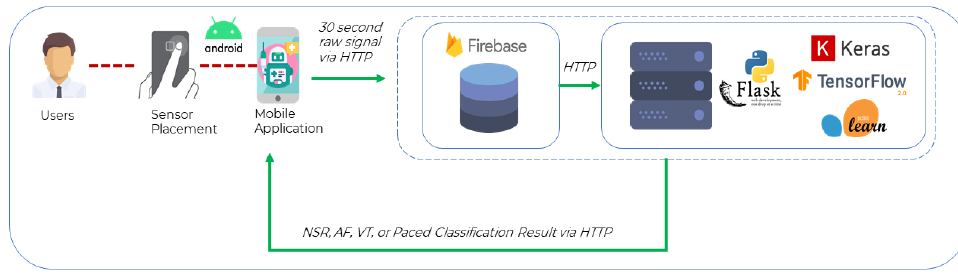
Figure 6. Implementation Architecture.